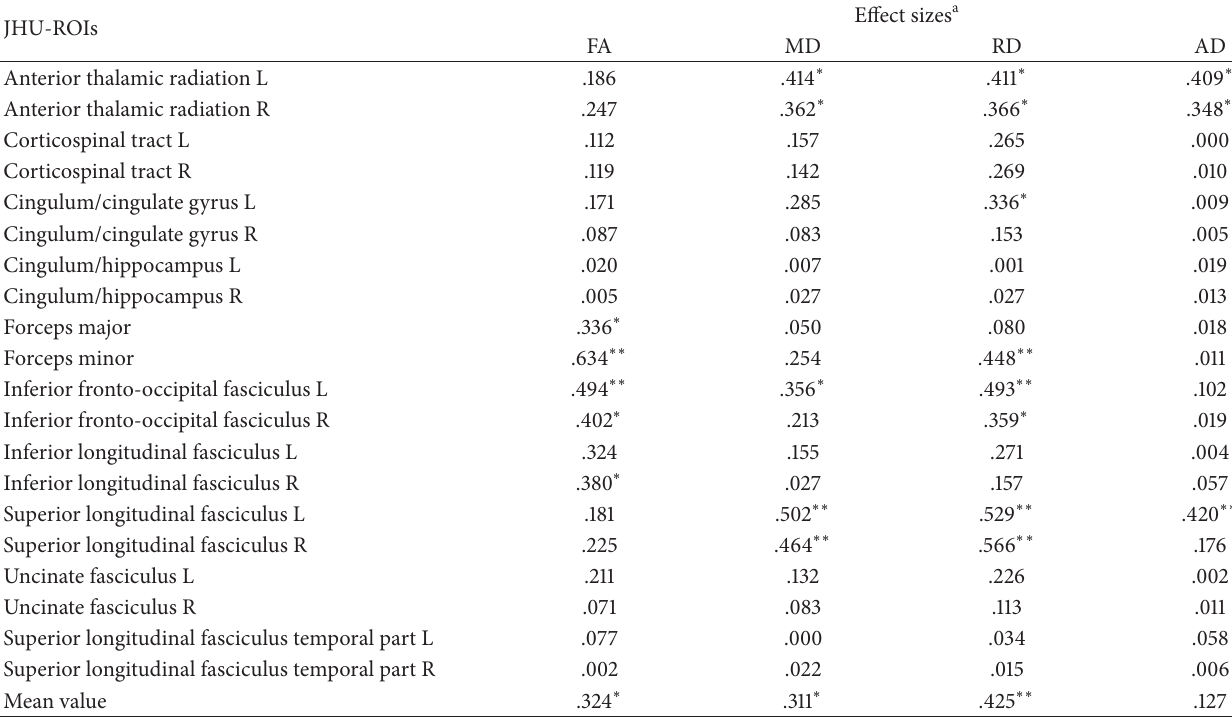
Values in the table represent effect sizes. L: left; R: right. FA: fractional anisotropy; MD: mean diffusivity; RD: radial diffusivity; AD: axial diffusivity. a Effect sizes are partial eta squared ( 𝜂 2